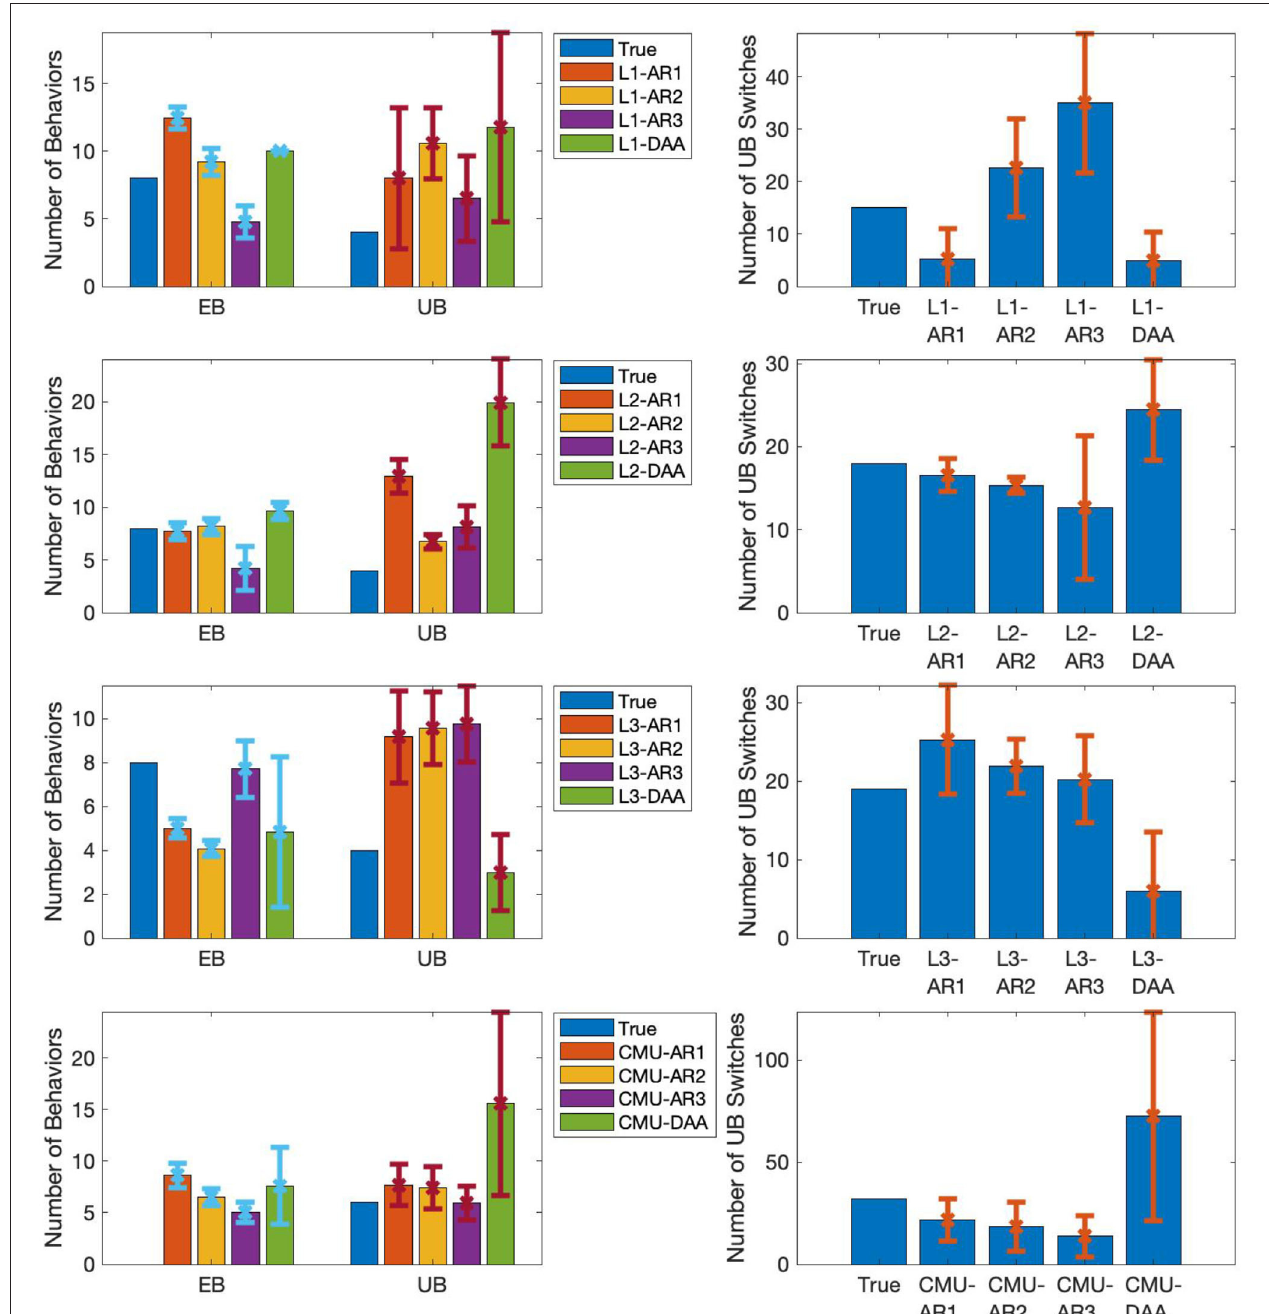
FIGURE 7 | Switching characteristics of estimated labels. (Left) Average number of discovered EBs and UBs for each experiment. Bars: 1 SD. (Right) Average number of switches in all time series sequences for each experiment. Bars: 1 SD.